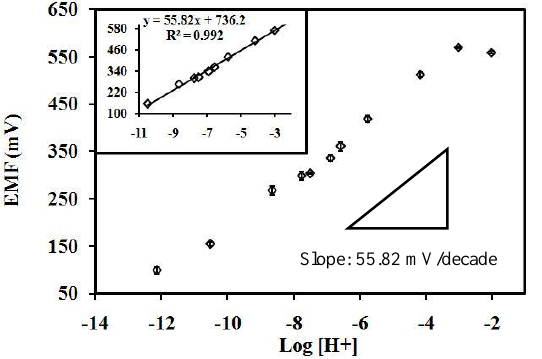
Figure 4. The response of a SPE based H + ion sensor to hydrogen ion concentrations (in 0.1 mM Tris-HCl